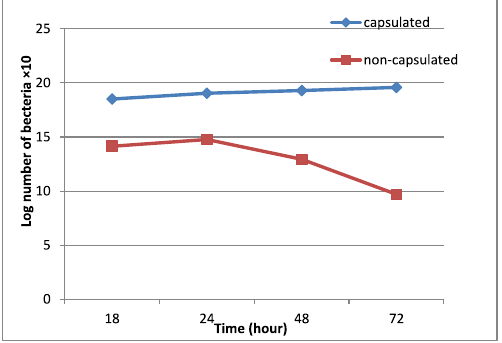
Fig. 3. Viable count of capsulated and non-capsulated K. ozaenae recovered from mice liver. Each dot acts log10 CFU per gm of liver (mean) for 3 mice.